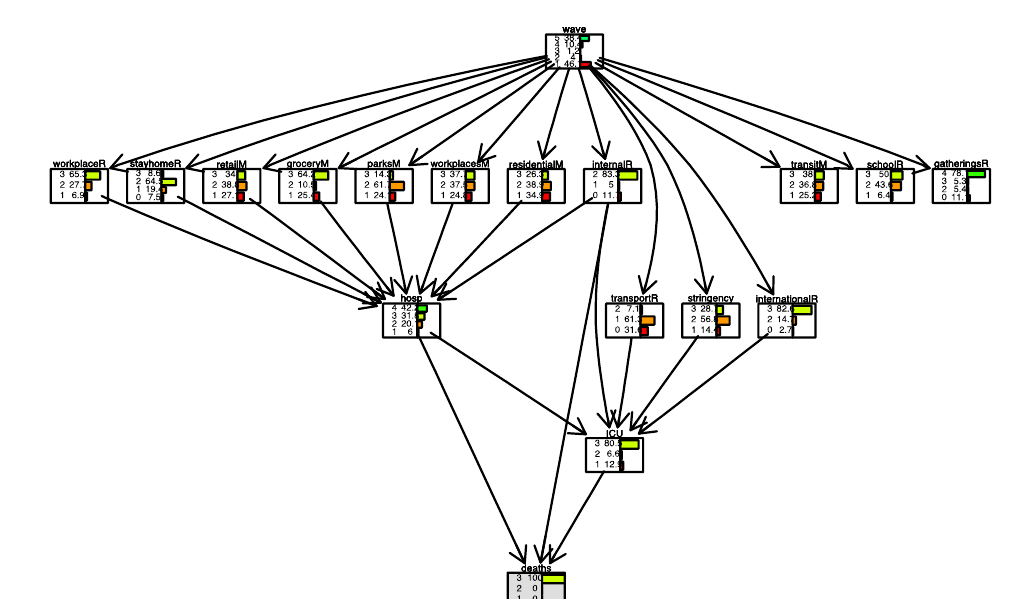
Figure 11. Scenario for Italy when daily deaths are larger than 500 (level 3). The deaths node is highlighted in